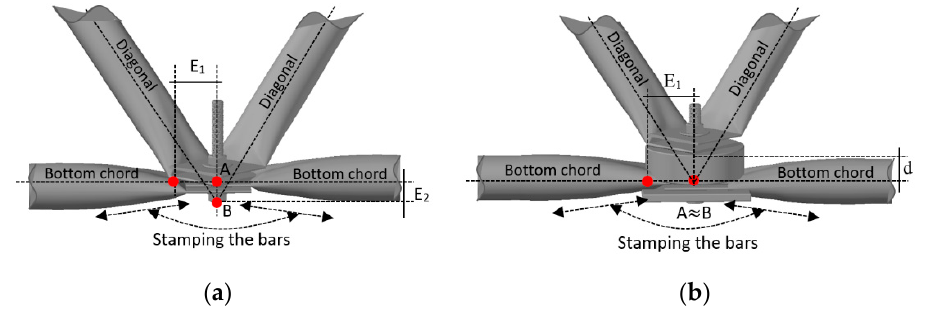
Figure 7. Proposal to correct the eccentricity [9], ( a ) typical connection with eccentricity, ( b ) correction of eccentricity “ d = E 2 ”in the connection.